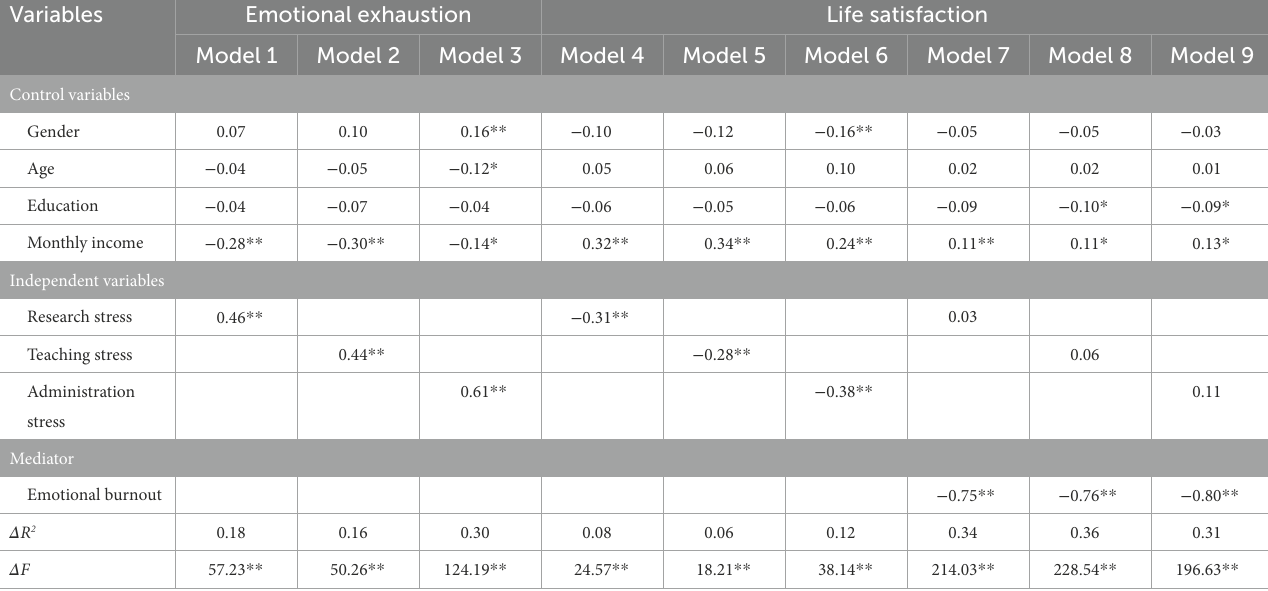
TABLE 3 Results of hierarchical multiple regression.